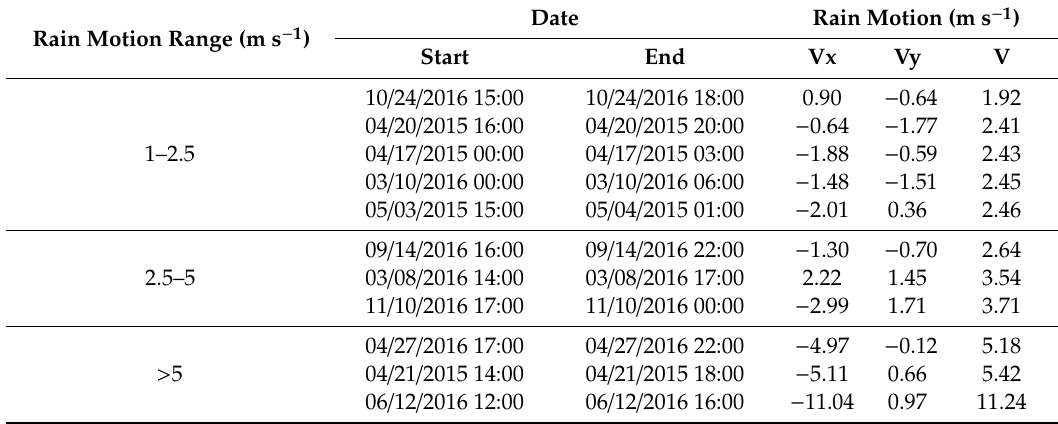
Table 5. Precipitation event groups according to rainfall motion.